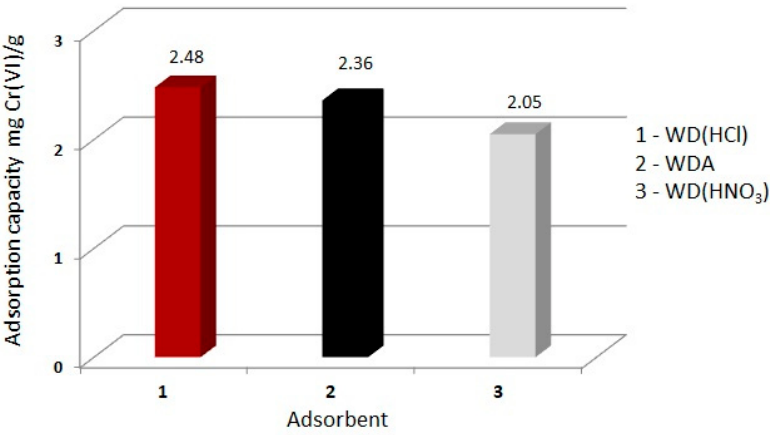
Figure 2. Influence of the carbon type on Cr(VI) adsorption capacity.